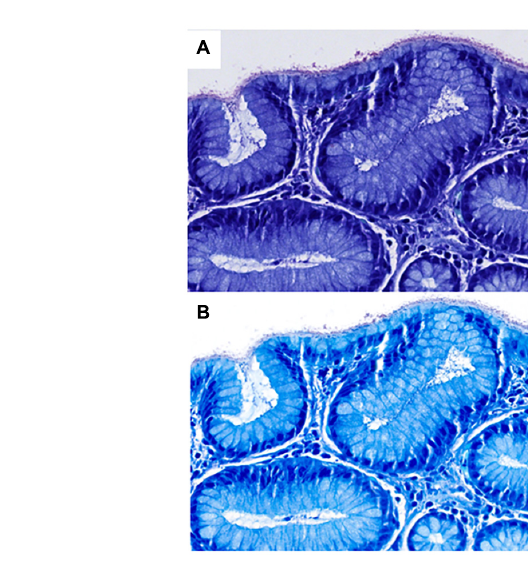
FIGURE2 Scanned Giemsa stains from two different scanners (A,B) used in diagnostic routine at our institute in a case of H. pylori gastritis (both at 40 × , images courtesy of Ursina Begré). Note the differences in color and brightness between scanners. In a survey of our MDs, scanner B provided a higher level of diagnostic security on Giemsa scans of gastric biopsies but both scanners performed similarly at 40 × . Therefore, Giemsa stains for gastric biopsies are scanned at higher magnification per default.